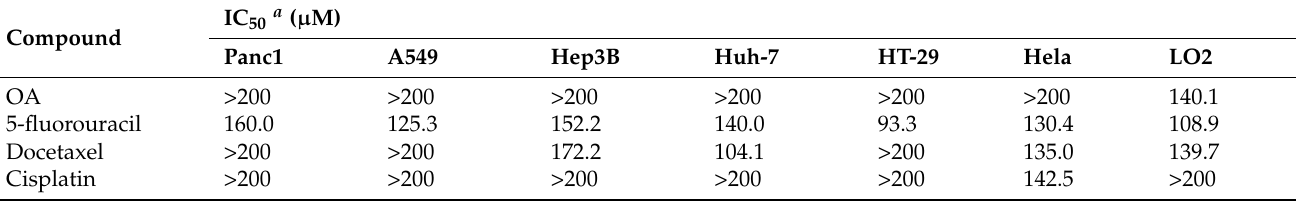
Table 2. In Vitro Cytotoxicity Data of OA and Its